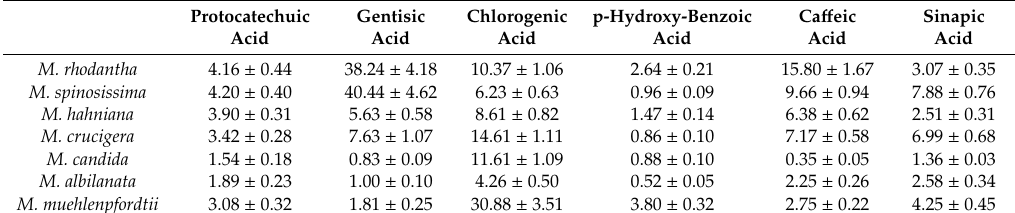
Table 1. The quantitative (mg 100g − 1 DW±SD) estimations of phenolic acids in Mammillaria sp. stem extracts. Protocatechuic Gentisic Acid Acid